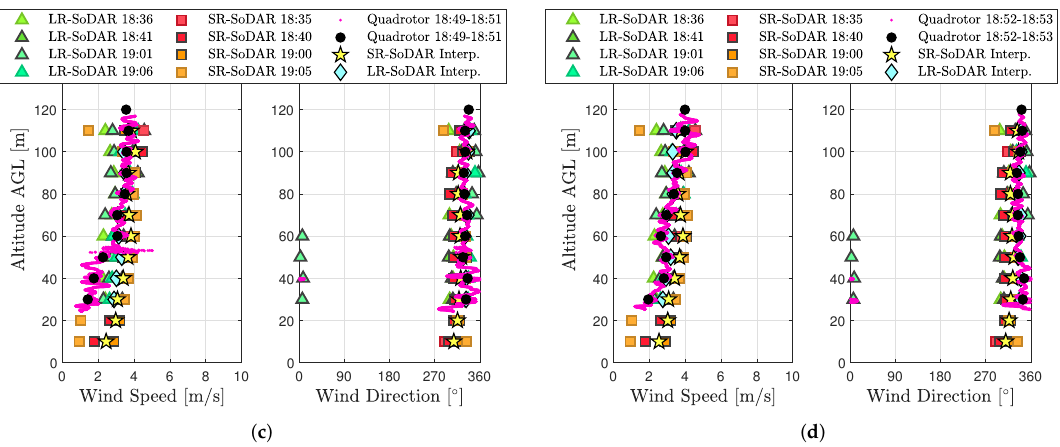
Figure A7. Comparison of wind speed and wind direction profiles from the SoDAR and quadrotor ascending vertically at 1.5 m/s between 10 and 120 m AGL from ( a ) 18:45 to 18:46 EDT, ( b ) 18:47 to 18:48 EDT, ( c ) 18:49 to 18:51 EDT, and ( d ) 18:52 to 18:53 EDT.